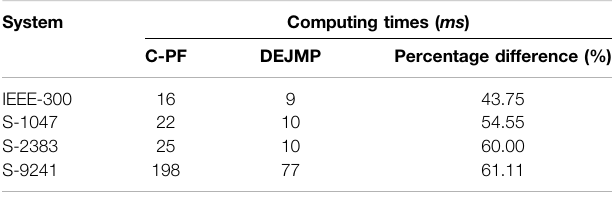
TABLE 2 | Computing times to obtain the Jacobian matrix.